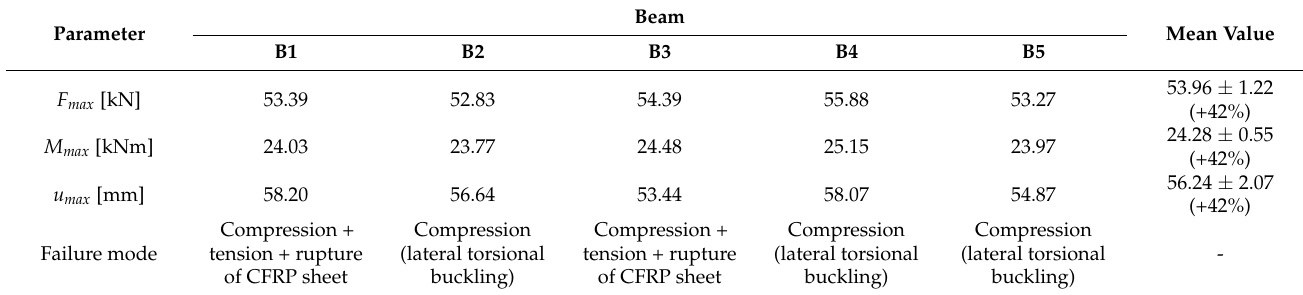
Table 6. Series B test